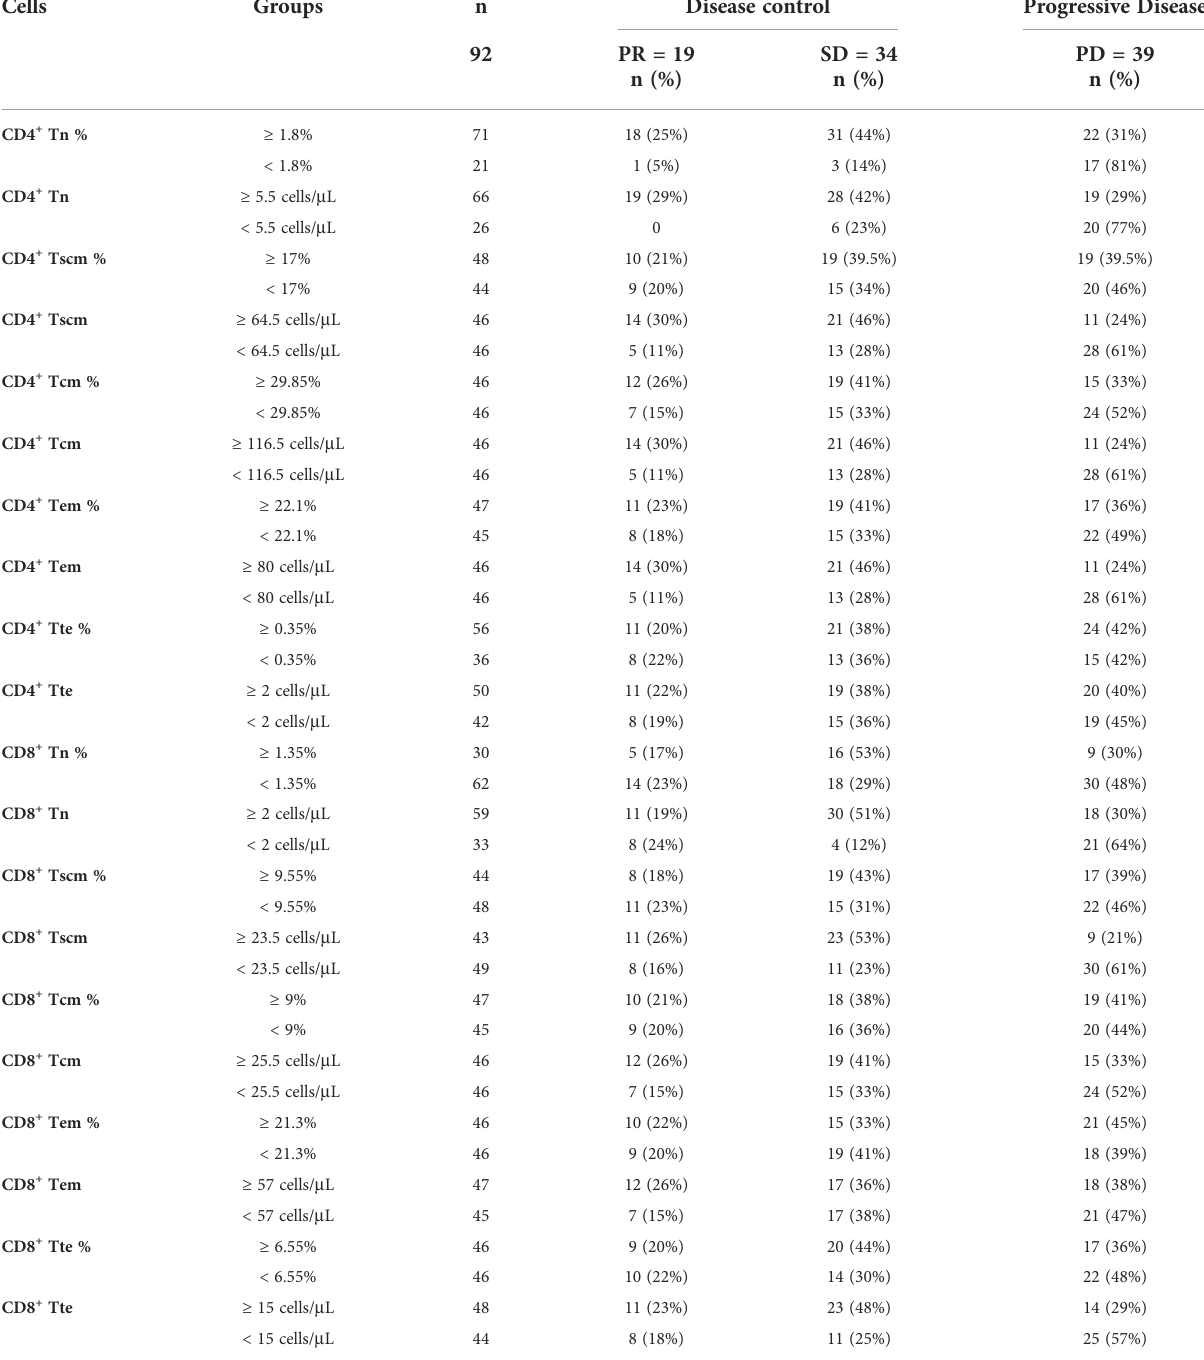
TABLE 6 Evaluation response of Tn/Tm of aNSCLCs received immunotherapy.